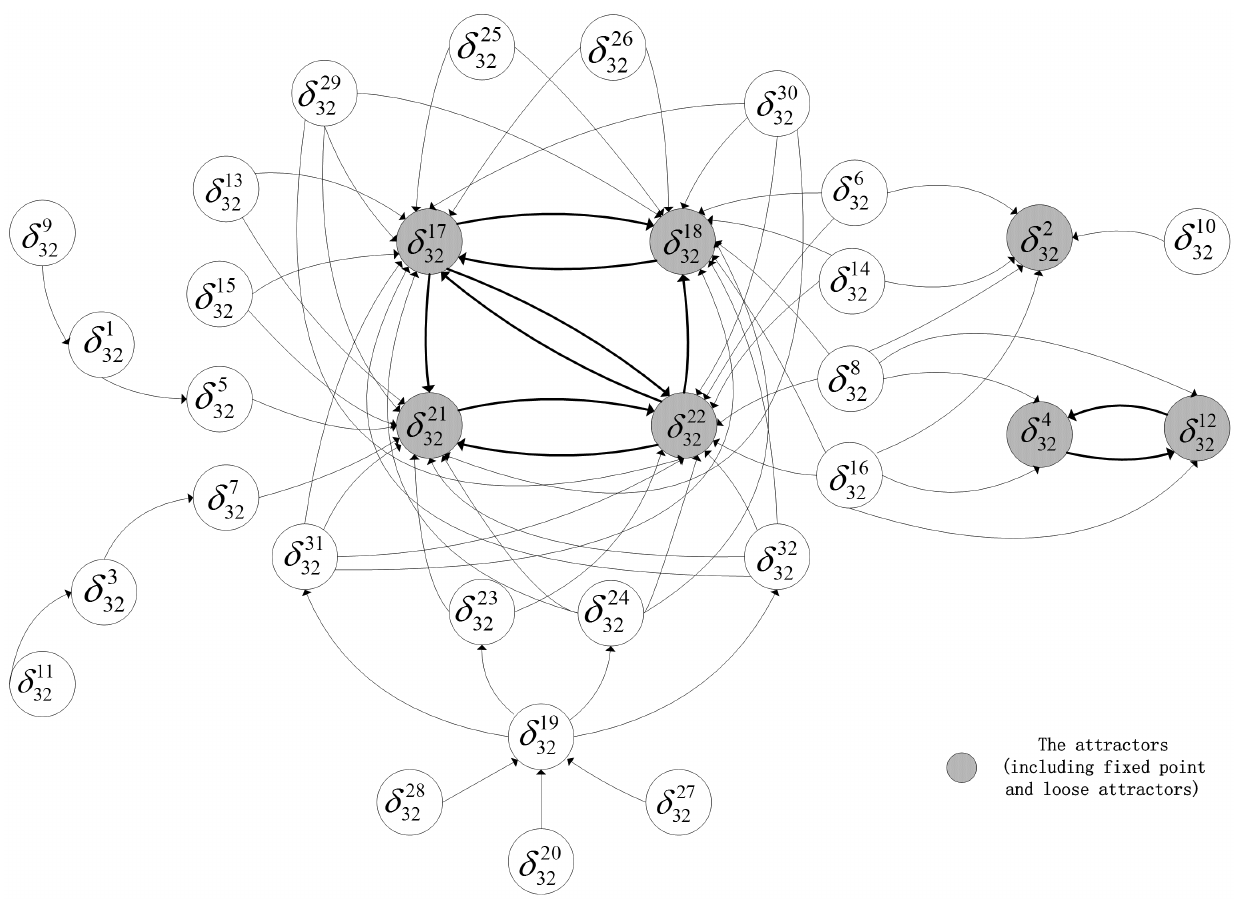
Figure 4. Attractors and basins of system (14).